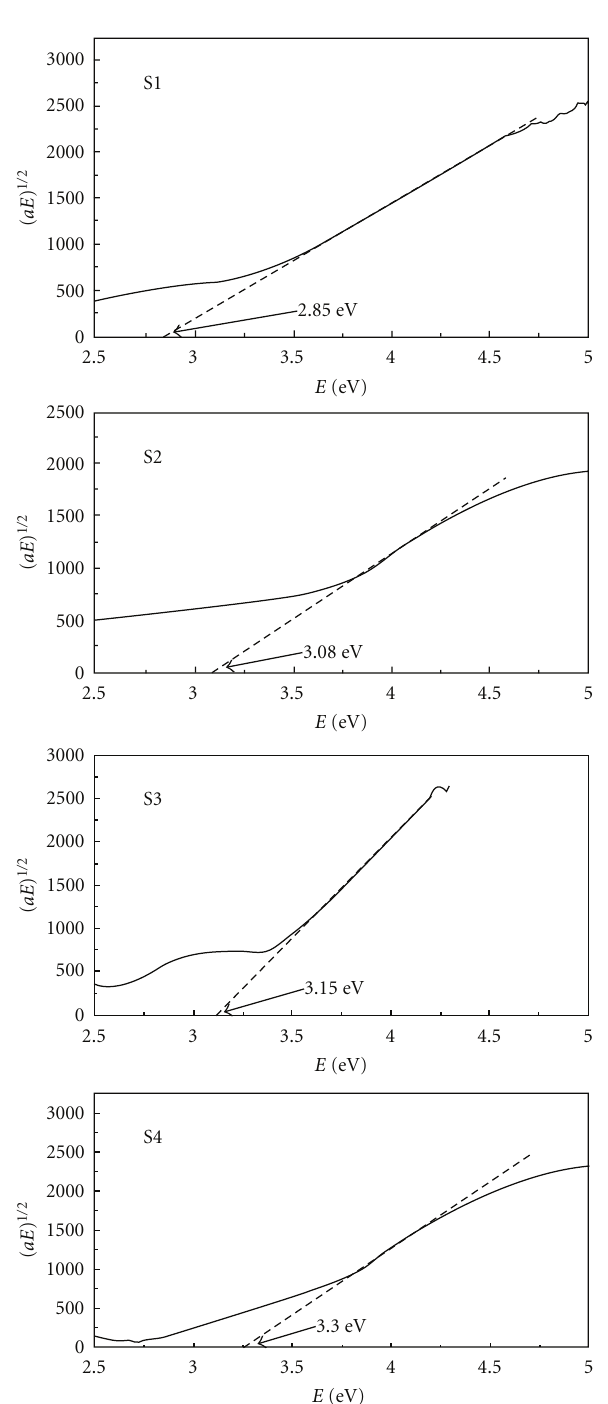
Figure 4: Tauc plot of ( αhγ ) 1 / 2 as a function of photon energy ( hγ ) for di ff erent amount of La 2 O 3 -doped TiO 2 thin films. measurements in the wavelength range of 200–700 nm.